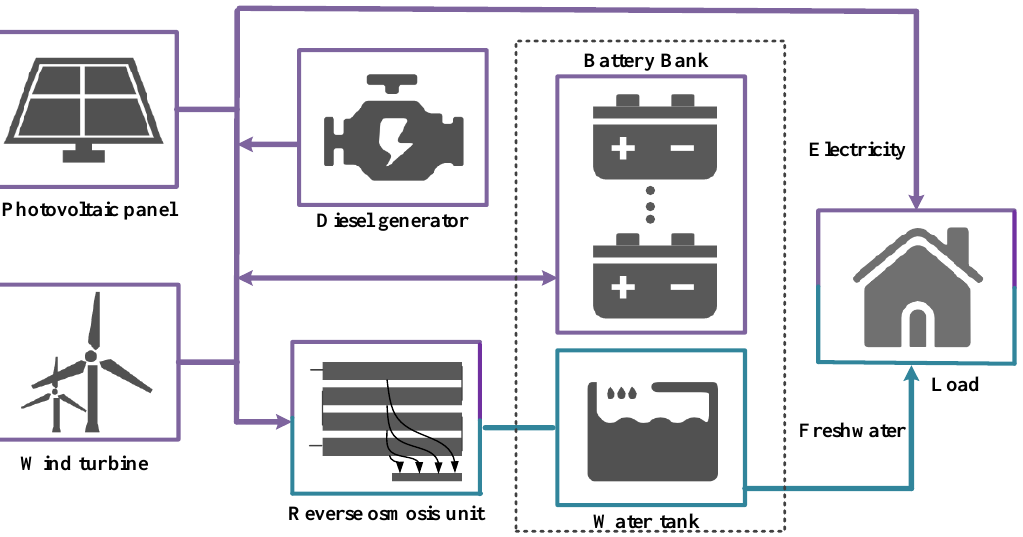
Figure 1. A schematic of an HES with multiple types of storage devices driving a ROD process.